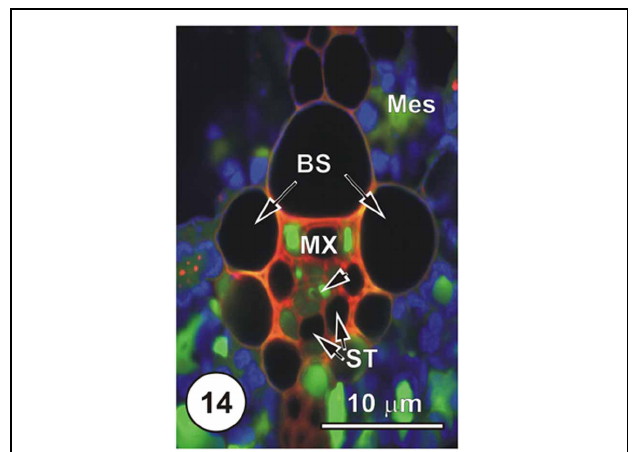
FIGURE 14 | LSCM imaged transections through a small (Figure 14), an intermediate (Figure 15) and a large (Figure 16) longitudinal bundles, showing distribution of 5,6-CF, after uptake of 5,6-CFDA (green fluorescence) co-transported with propidium iodide (red fluorescence; PI stains lignin and cellulosic walls) after 45min uptake and 6cm above the cut end of a rice leaf blade [full methodology in Botha et al. (2008)]. Chloroplast- containing mesophyll cells (Mes) have been false colored to blue to prevent interference with propidium iodide or the 5,6-CF dyes. Serial sections were cut directly into silicone oil and sections were covered with coverslips prior to examination using a Leica SP2 LCSM. Propidium iodide selectively stained lignified walls (red fluorescence). Small vein, showing that 5,6-CF had been offloaded into xylem parenchyma, either side of the solitary metaxylem vessel (MX) Note that the two thin-walled sieve tubes (ST, abaxial) contain no evidence of the probe, but thick-walled sieve tubes (dart below the metaxylem vessels). There is no evidence that 5,6-CF has offloaded to the bundle sheath (BS), but it is evident as well as in mesophyll (Mes), indicating symplasmic transport outwards into the